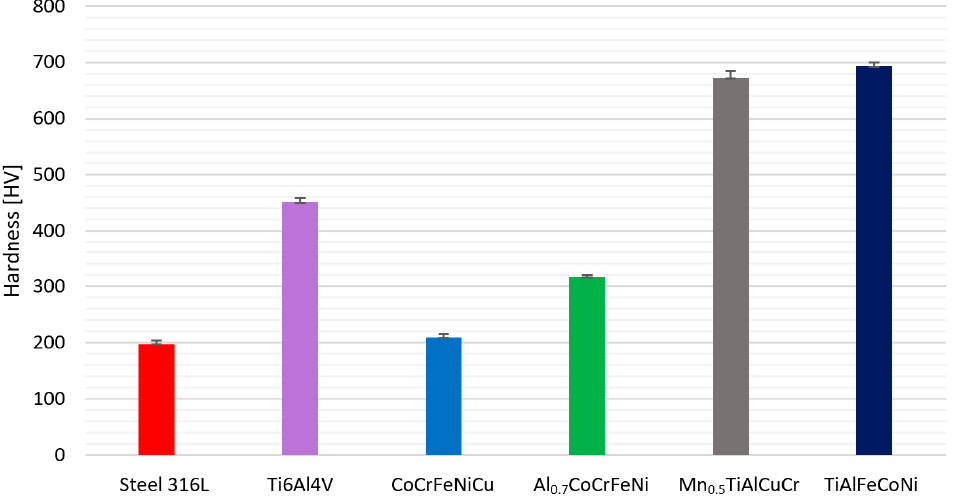
Figure 4. SEM images of Mn 0.5 TiCuAlCr alloy, magnification: ( a ) 1000 × , ( b ) 2000 × . Table 5. The chemical composition of Mn 0.5 TiCuAlCr alloy.